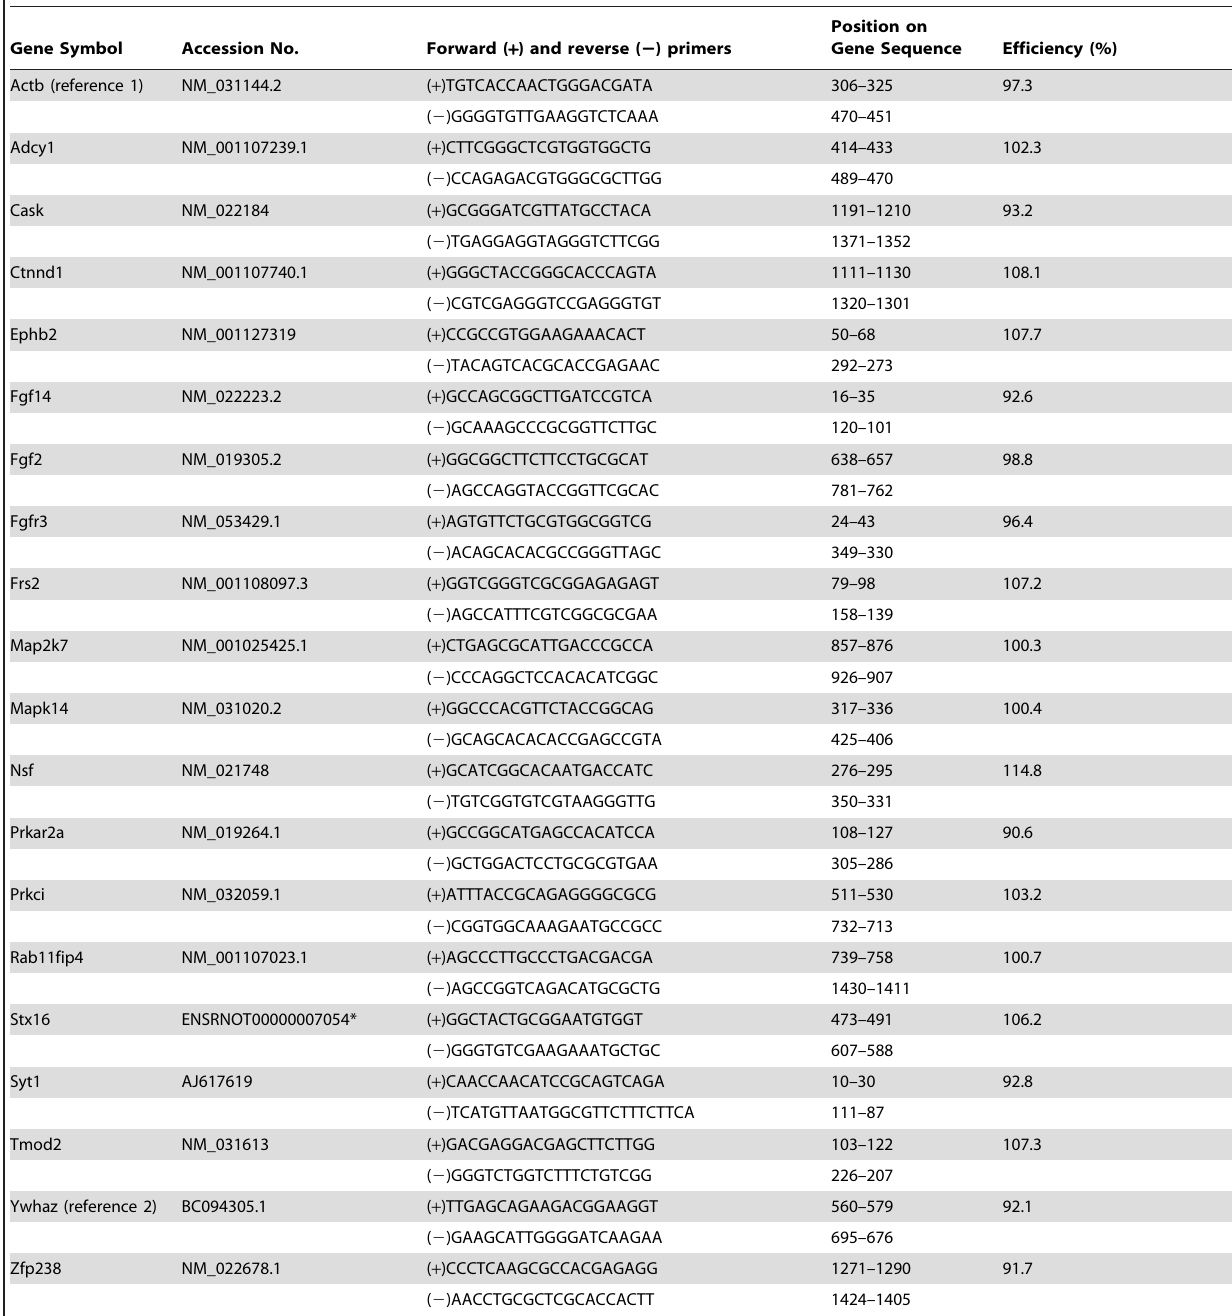
Table 1. Forward and reverse primers used for genes validated with